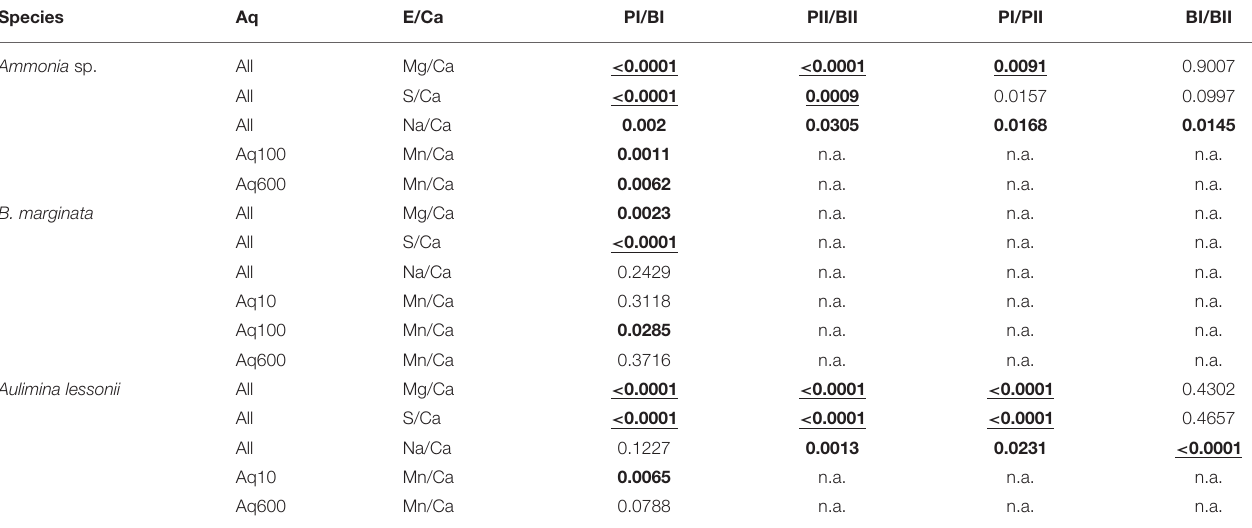
TABLE 4 | Two-tailed p- values of unpaired t -test of comparison of means of primary and secondary peak (PI and PII) and base (BI and BII) values of E/Ca acquired by EPMA. Species Ammonia sp.